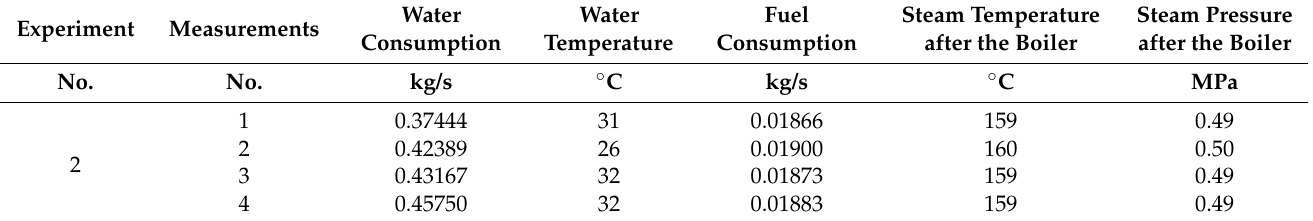
Table 4. Experimental values of Steam boiler 2.